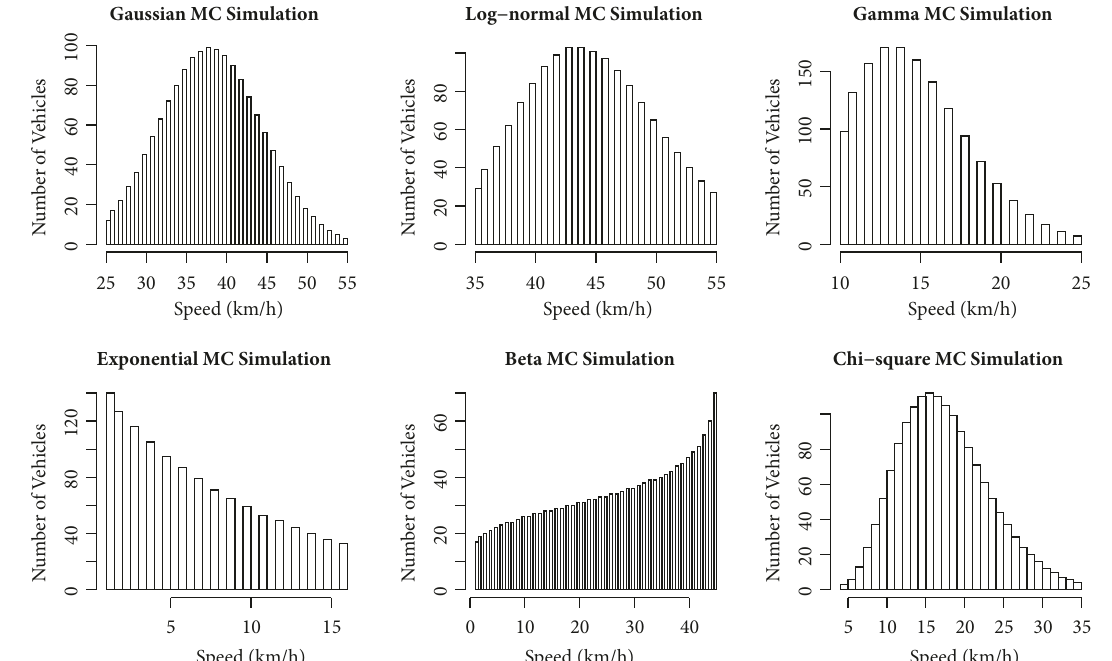
Figure 2: Random speed generation by Monte Carlo (MC) Simulation.